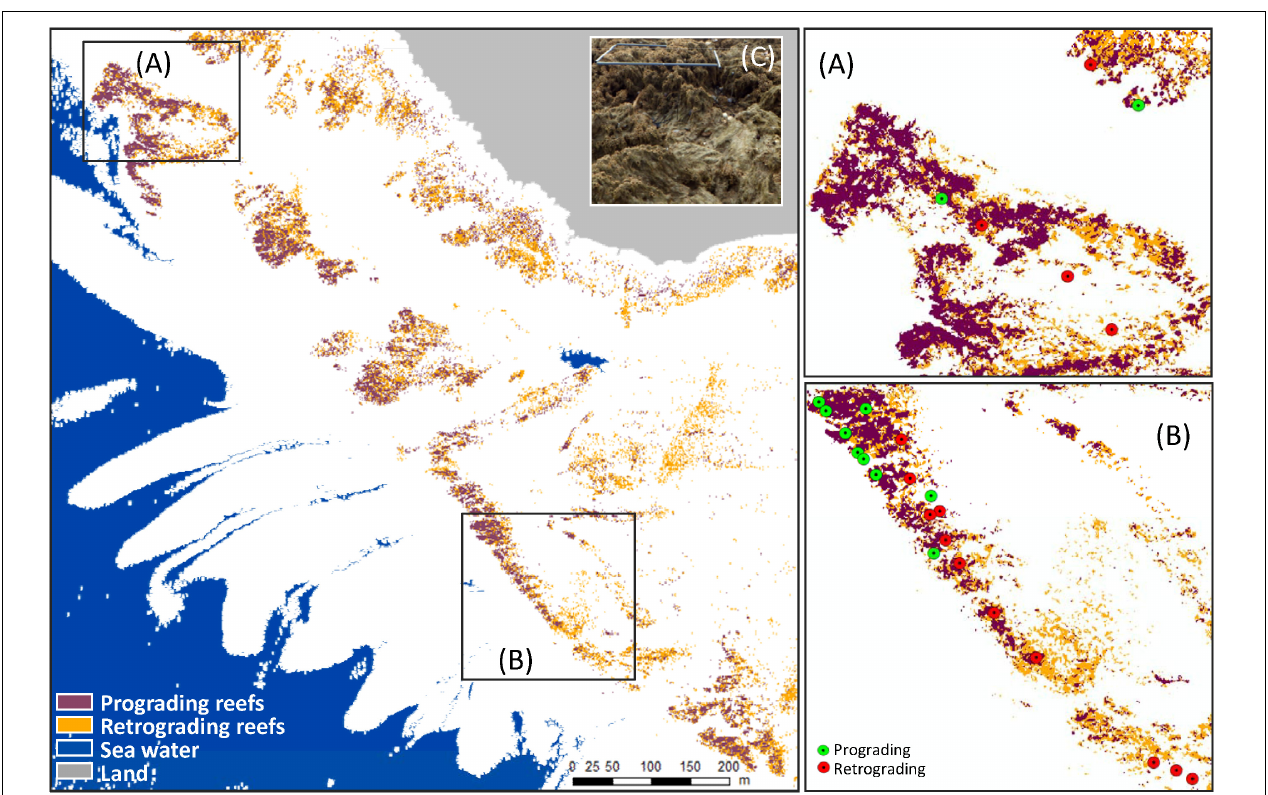
FIGURE 8 | Sabellaria alveolata reef ecological status distribution in Champeaux showing zones displaying plotted field samples on ecological status classification (A,B) and field photography with a quadrat of 0.5 × 0.5 cm on S. alveolatta reef exhibiting high spatial variability in ecological status (C) : prograding reef at the back of the image and retrograding reef in front of the